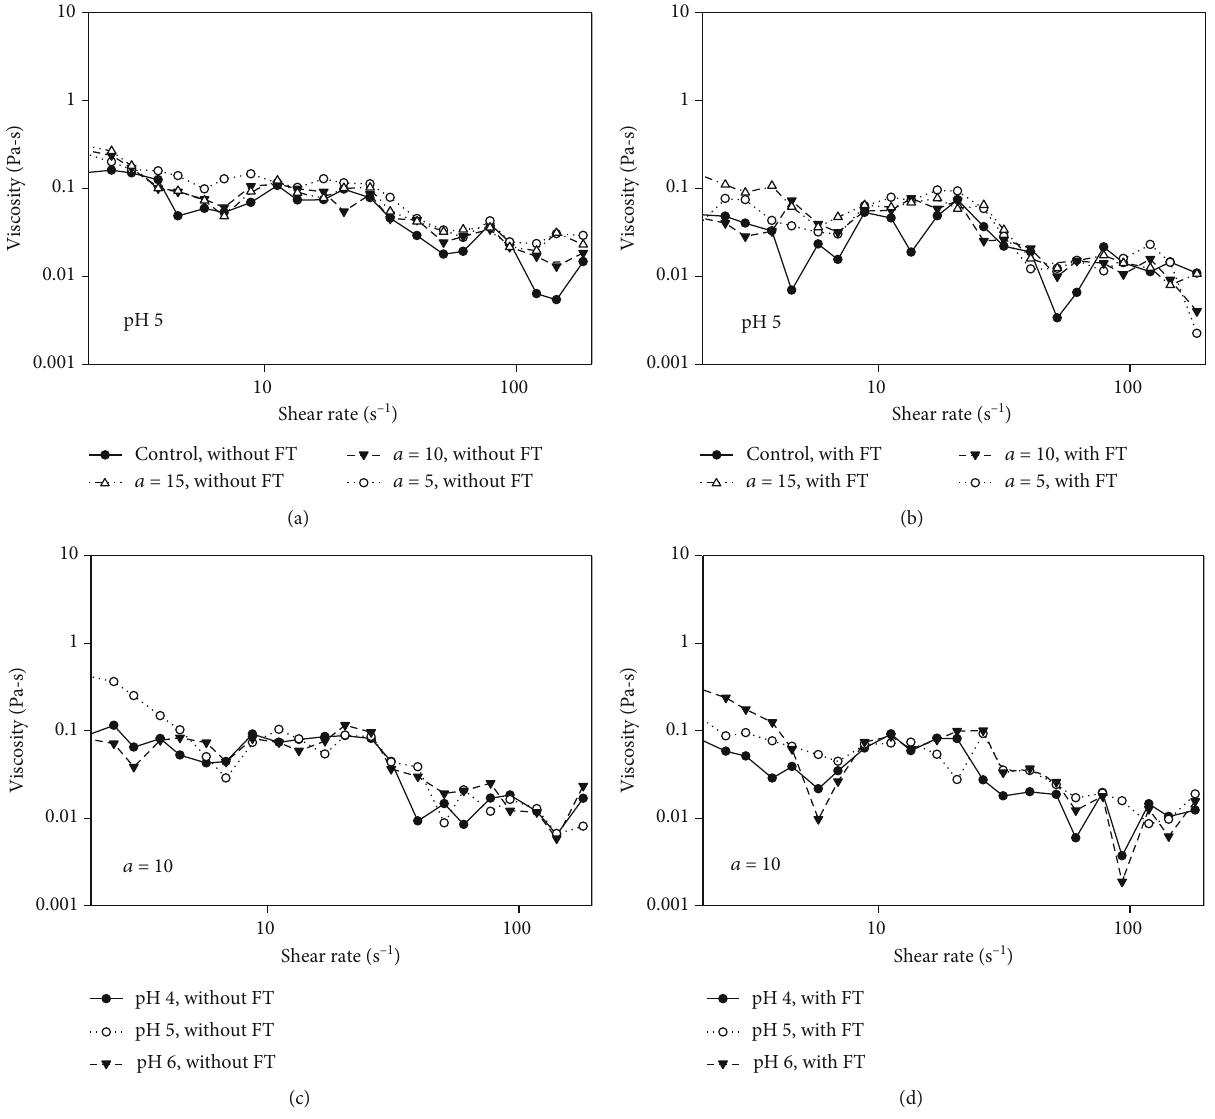
Figure 4: E ff ect of mixing ratio (a, b) and pH (c, d) on the viscosity of a whey protein isolate — puri fi ed microwave-extracted pectin complex with and without freezing and thawing